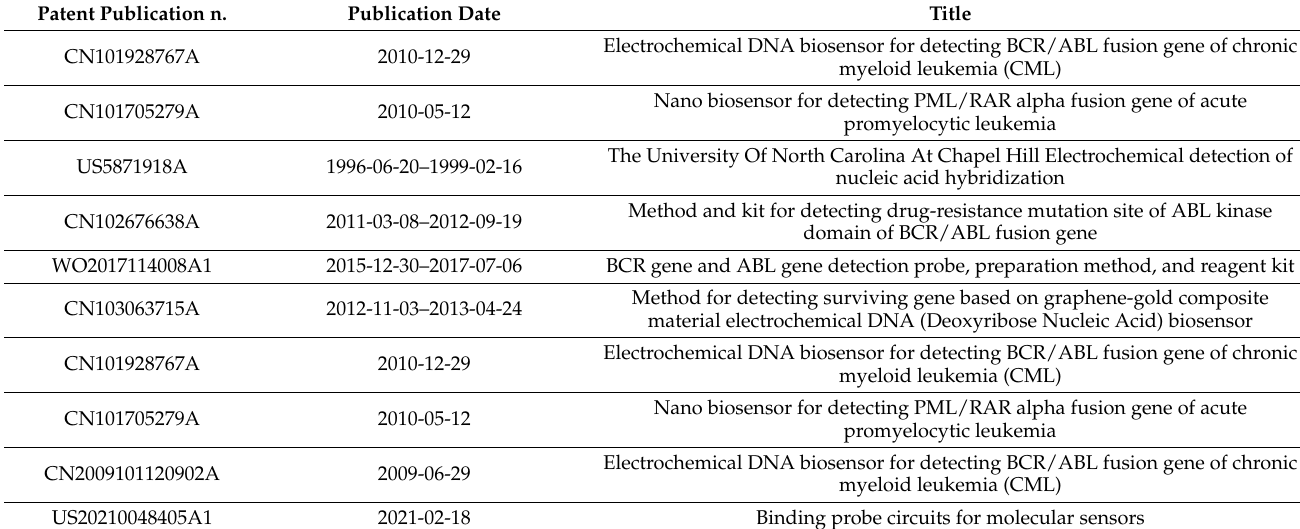
Table 3. Some of the patented (nano)biosensors that could be used in the diagnosis of hematological